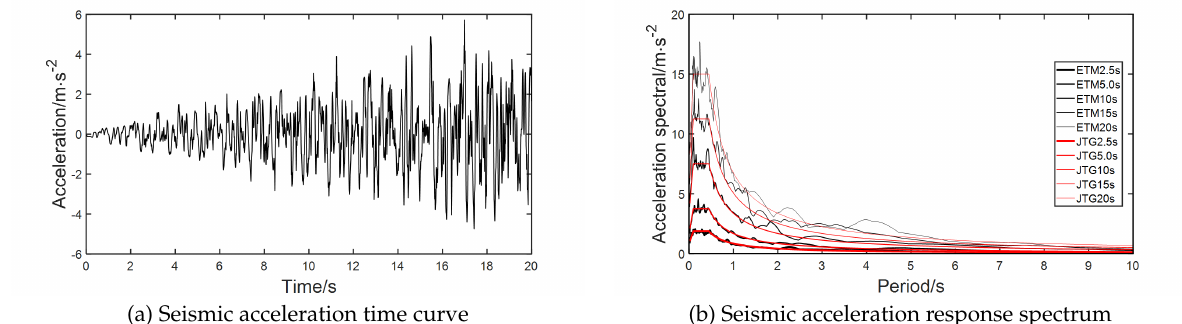
Fig. 10. Endurance time accelerogram and corresponding response spectra